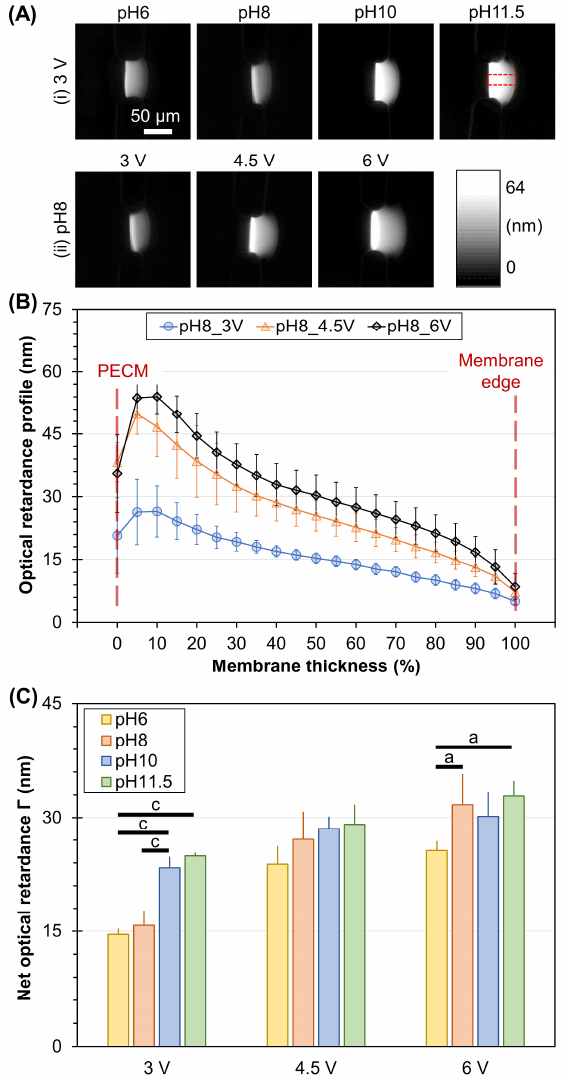
Figure 5. Optical retardance of electrofabricated chitosan membranes. ( A ) Representative optical retardance map of chitosan membranes electrofabricated using ( i ) fixed voltage at 3 V while varying pH of alginate solution and ( ii ) fixed pH of alginate solution at 8 while varying the applied voltage. ( B ) Profile plots of optical retardance within chitosan membrane with respect to the percentage of membrane thickness. ( C ) Net optical retardance of chitosan membranes electrofabricated under varying electrofabrication conditions. Results of pairwise comparisons are indicated by a ( p < 0.05) and c ( p < 0.001), with Tukey test comparisons indicated by horizontal bars connecting the compared groups.